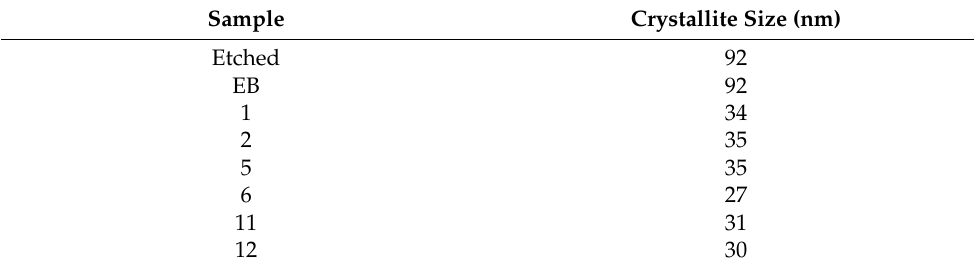
Figure 6. XRD pattern of etched and EB-treated Ti and samples 5 and 6 (Bragg–Brentano). The peaks of a distorted α″ orthorhombic phase are indicated by the asterisk (*) symbol. The XRD pattern of sample 5 shows the presence of peaks (38.85°, 56.26° and 70.81°) that could be attributed to a distorted α″ orthorhombic phase, with a higher amount of Nb. The presence of a phase richer in Nb is also confirmed by the EDS maps, where Nb-rich regions are visible. Table 5. Crystallite size of set I samples.